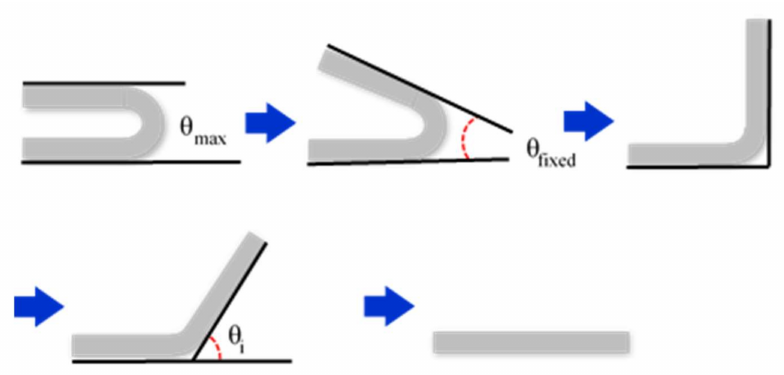
Figure 4. Process for testing the shape fixation properties: maximum bending angle and fixed bending